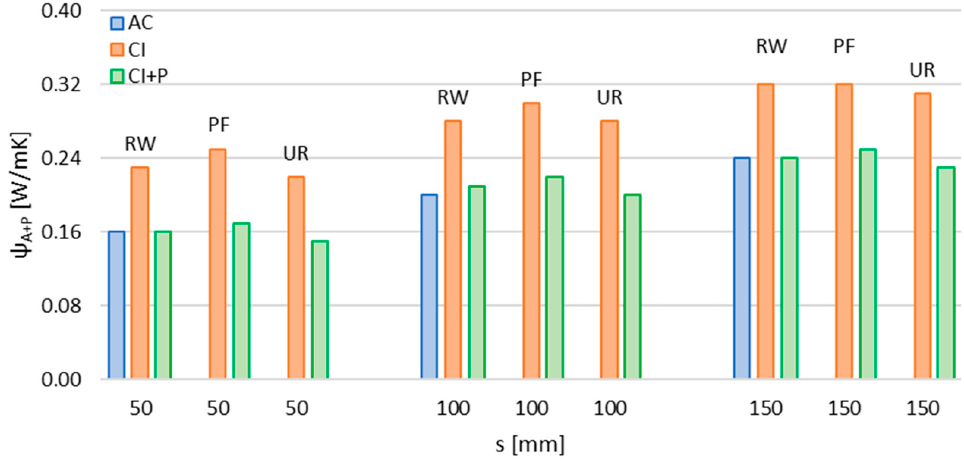
Figure 3. Linear thermal transmittance Ψ ie of edge thermal bridge with pillar.